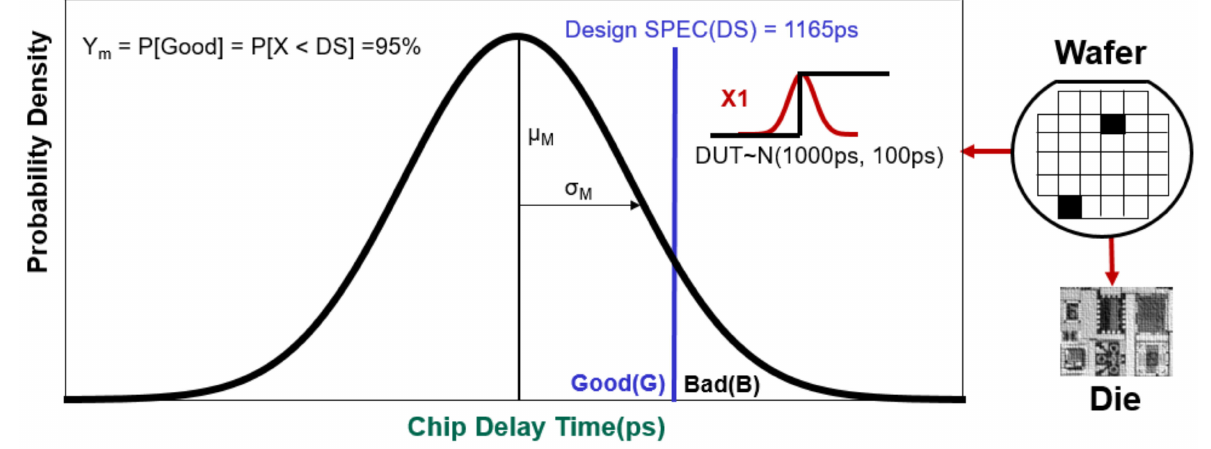
Figure 2. Distribution and calculation of manufacturing yield.